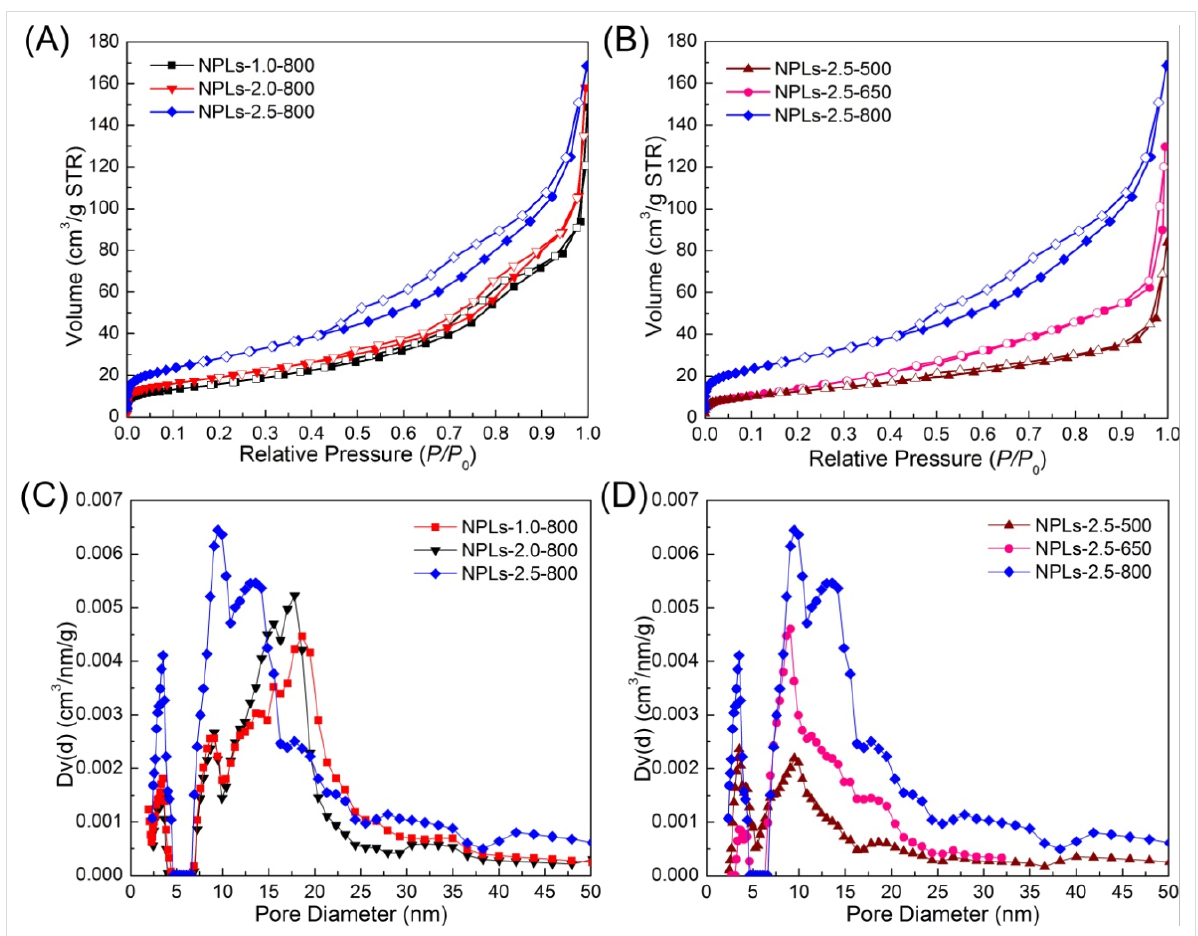
Figure 4: (A) and (B) Nitrogen adsorption–desorption isotherms of the NPLs prepared under different conditions. (C) and (D) Corresponding pore size distributions derived from the adsorption branches using the NLDFT method.